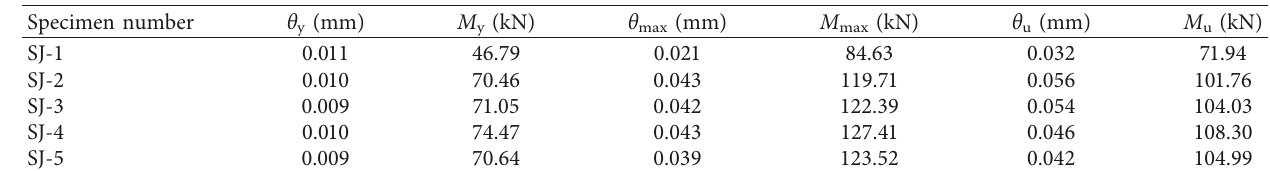
Table 3: Moment and rotation at different stages.